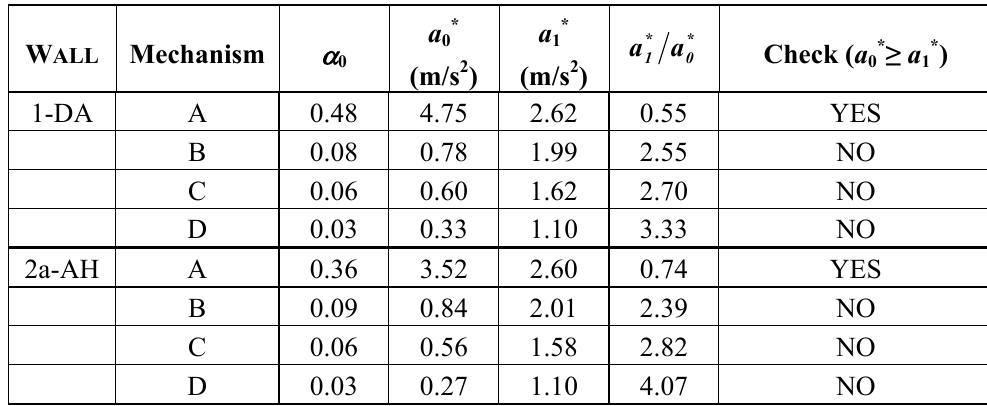
Table 3. Vulnerability indexes obtained with kinematic analysis (  a 0* = seismic spectral accelerations corresponding to  demanded for ultimate limit